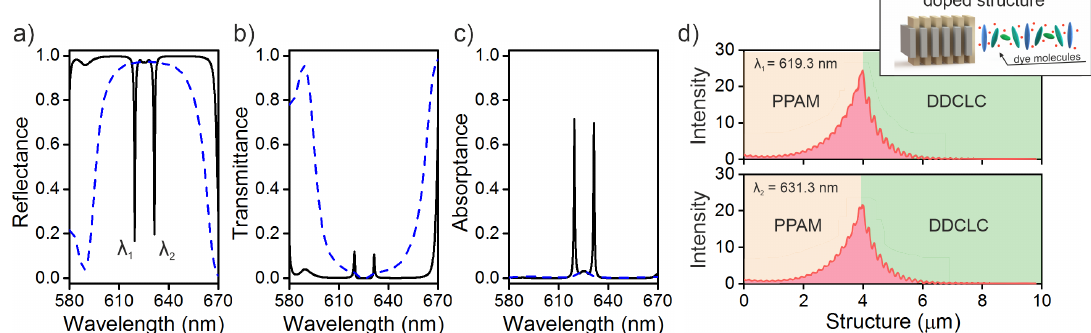
Figure 2. ( a ) Reflectance, ( b ) transmittance, and ( c ) absorptance spectra of the PPAM-DDCLC structure. The solid curve corresponds to the diffracting polarization and the dashed curve, to the nondiffracting one. The damping parameters are γ = 4 × 10 12 s − 1 and f = 2 × 10 28 s − 2 . The rest parameters are the same as in Figure 1b. ( d ) Spatial distribution of the local field intensity in the sample normalized to the initial